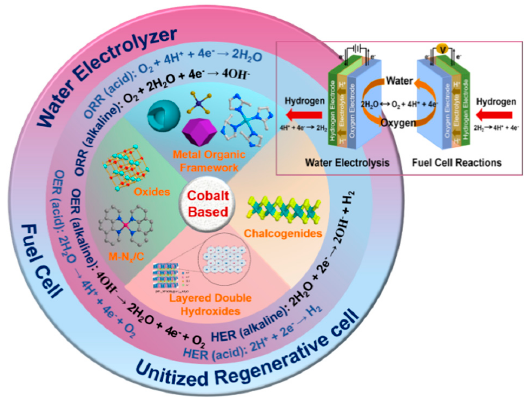
Figure 1. Schematic organization of the cobalt-based catalysts (CoCat) including layered double hydroxides, chalcogenides, oxides, M–N x /C and metal organic framework with some major